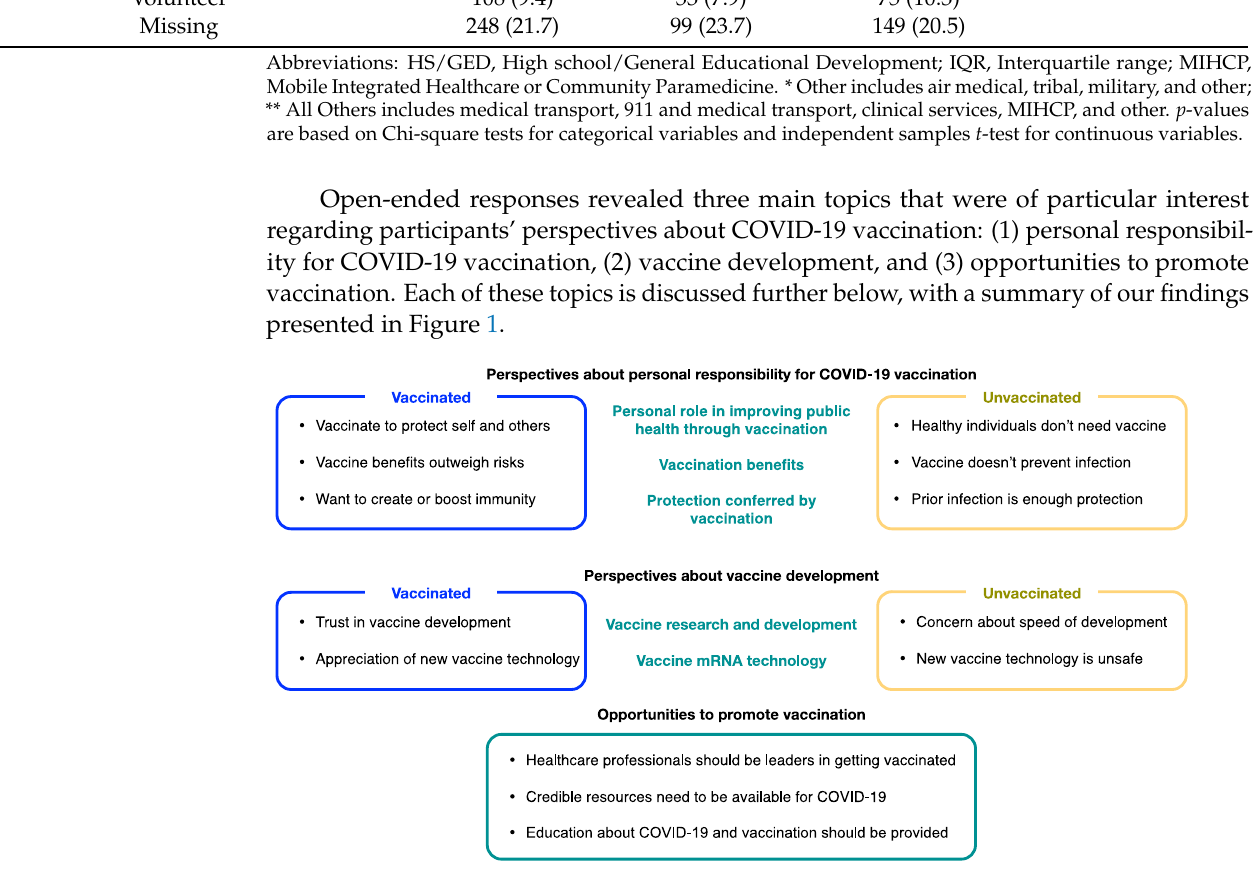
Figure 1. Perspectives of EMS Professionals about COVID-19 vaccination.